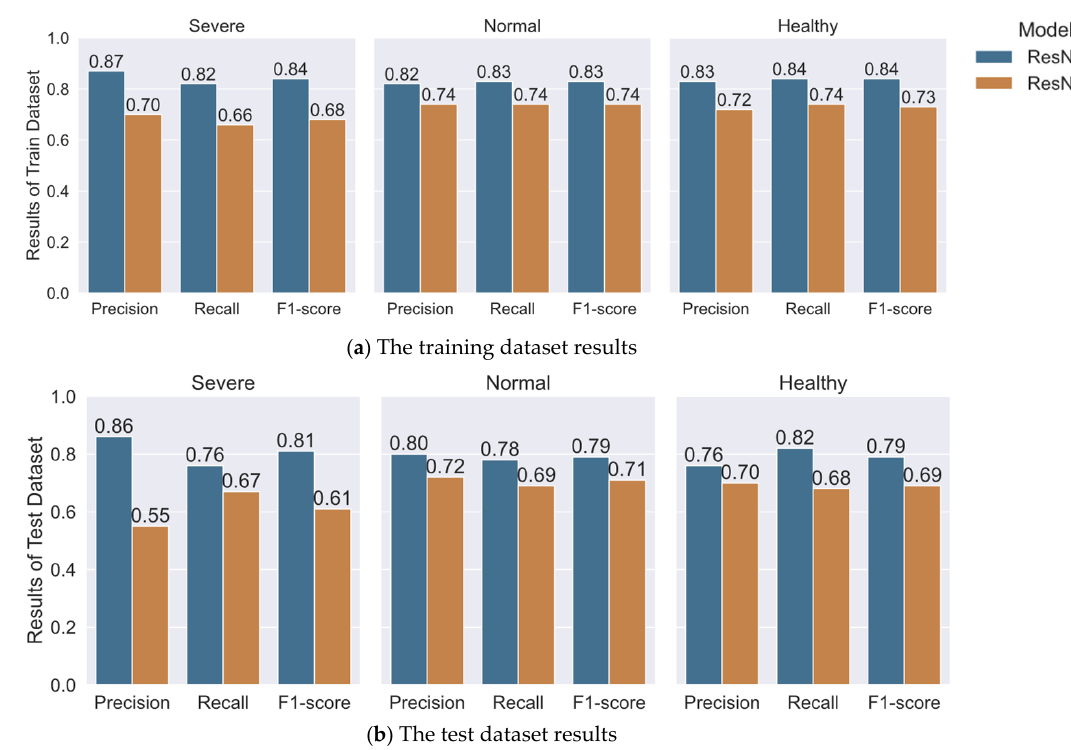
Figure 4. Hair follicle classification results of Train dataset in ( a ) and Test dataset in ( b ) compared between ResNet-101 and ResNet-50.